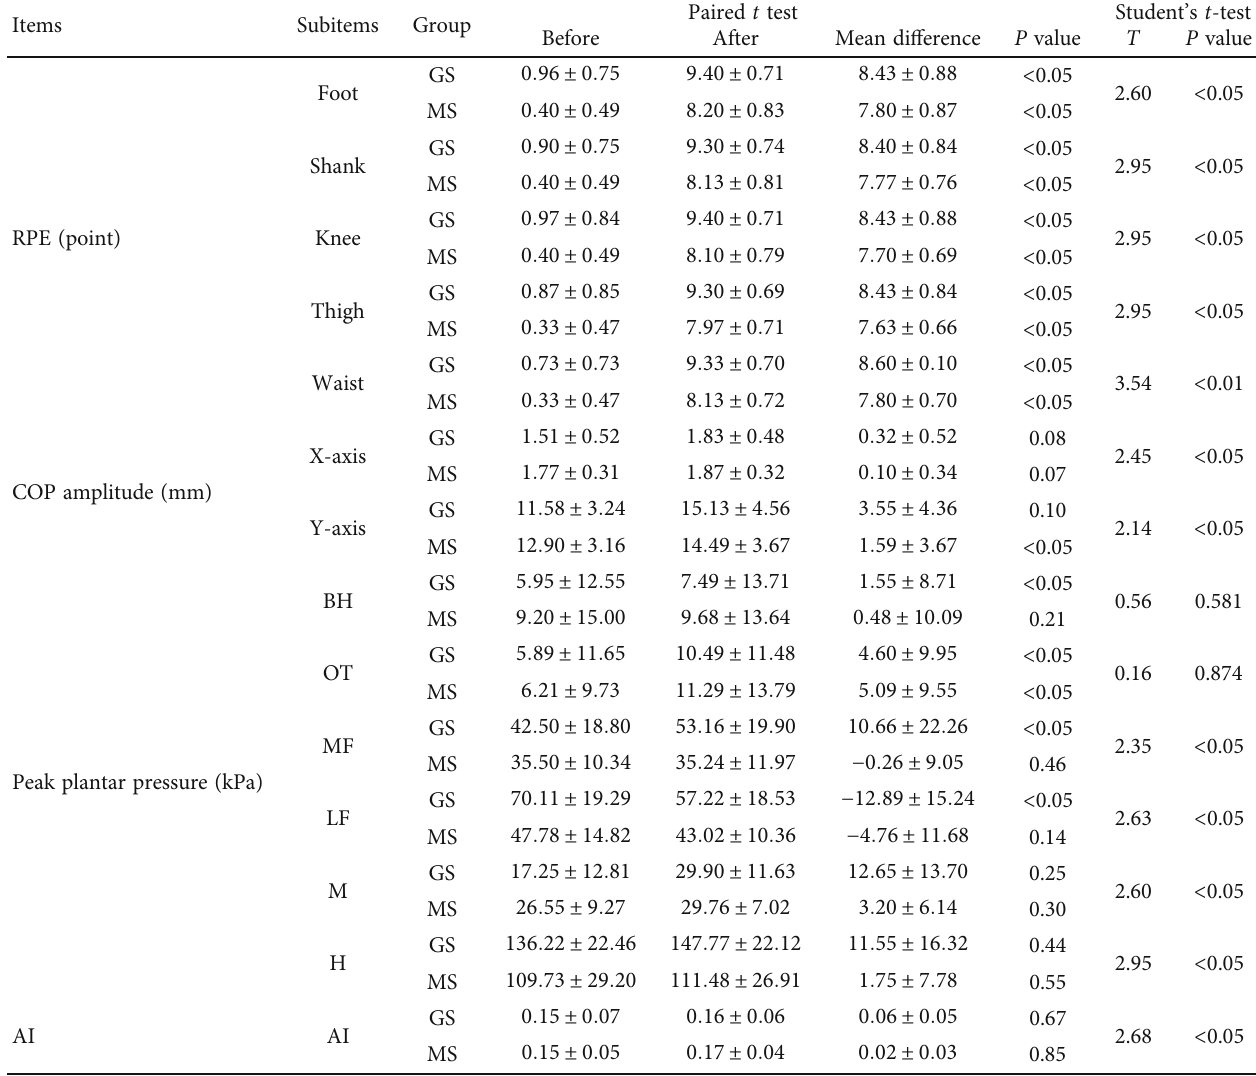
Table 2: Comparison of perceived exertion and foot biomechanical parameters change within and between groups. Items Subitems